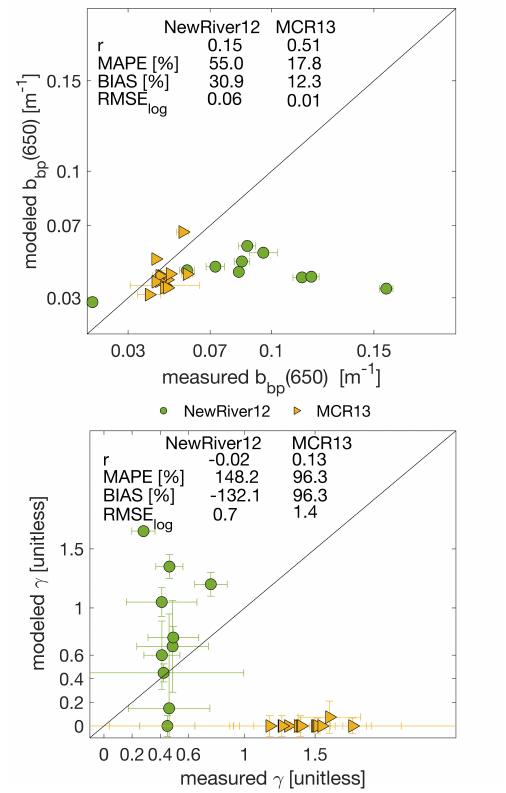
( 650 ) ( top panel ) and gamma ( bottom panel ) Figure 6. Field measured and MW constrained b ∗ bp for NewRiver12 and MCR13 dataset. γ was calculated using the red (651 nm) and NIR (878 nm) wavelengths for the NewRiver12 dataset and the green (532 nm) and red (650 nm) wavelengths for the MCR13